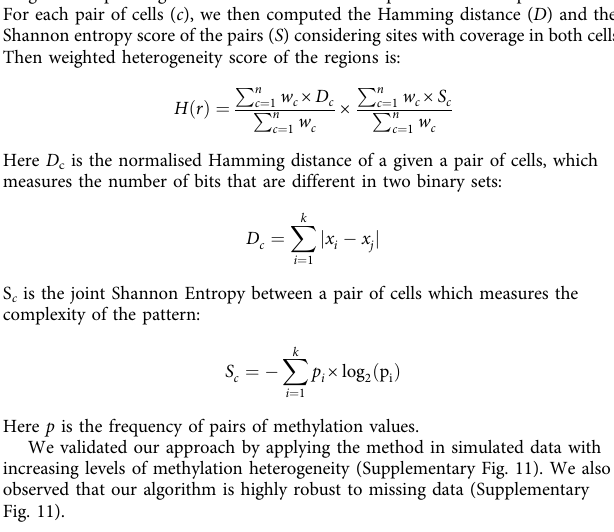
Fig. 4 Changes in cell-to-cell methylation heterogeneity during ageing. a Normalised methylation heterogeneity changes with age ( Δ methylation heterogeneity: old – young) across different genomic features (Chip-seq data from 2-months-old mice 20,27 , Ac: activated muscle stem cells). For all boxplots, the box represents the interquartile range and the horizontal line in the box represents the median. b Genome-wide normalised